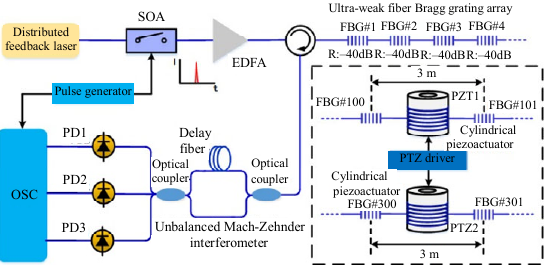
Fig. 1 Schematic of high-speed Mach-Zehnder-OTDR distributed optical fiber vibration sensor using medium-coherence laser. SOA: semiconductor optical amplifier, EDFA: erbium-doped fiber amplifier, CIR: circulator, PD: photodetector, and OSC: